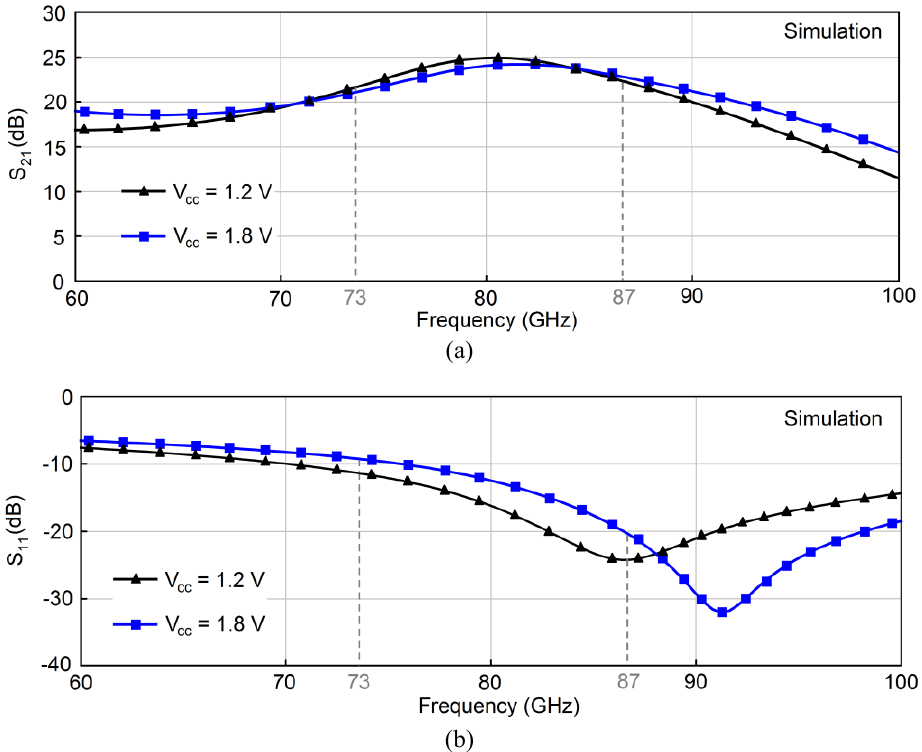
Fig. 3. Simulated S 21 (a) and S 11 (b) at different supply